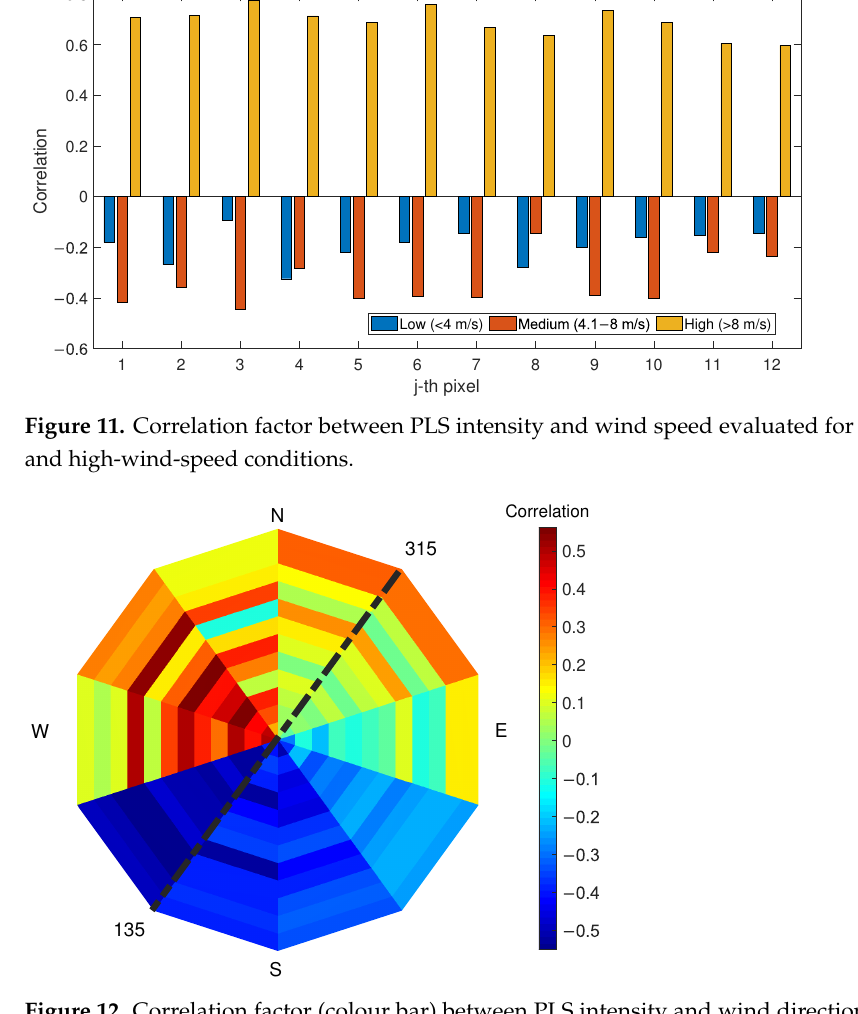
Figure 12. Correlation factor (colour bar) between PLS intensity and wind direction evaluated for different overlapping sectors ranging in 90° wind directions. In the figure, each sector represents a 90° wind-direction section and each of the 12 rings represent a row of pixels starting from pixel 1, which is located on the sea-side (inner ring), and moving towards pixel 12 (external ring), which is located on the city-side of the study area. The dotted black line represents the orientation of the shore line in